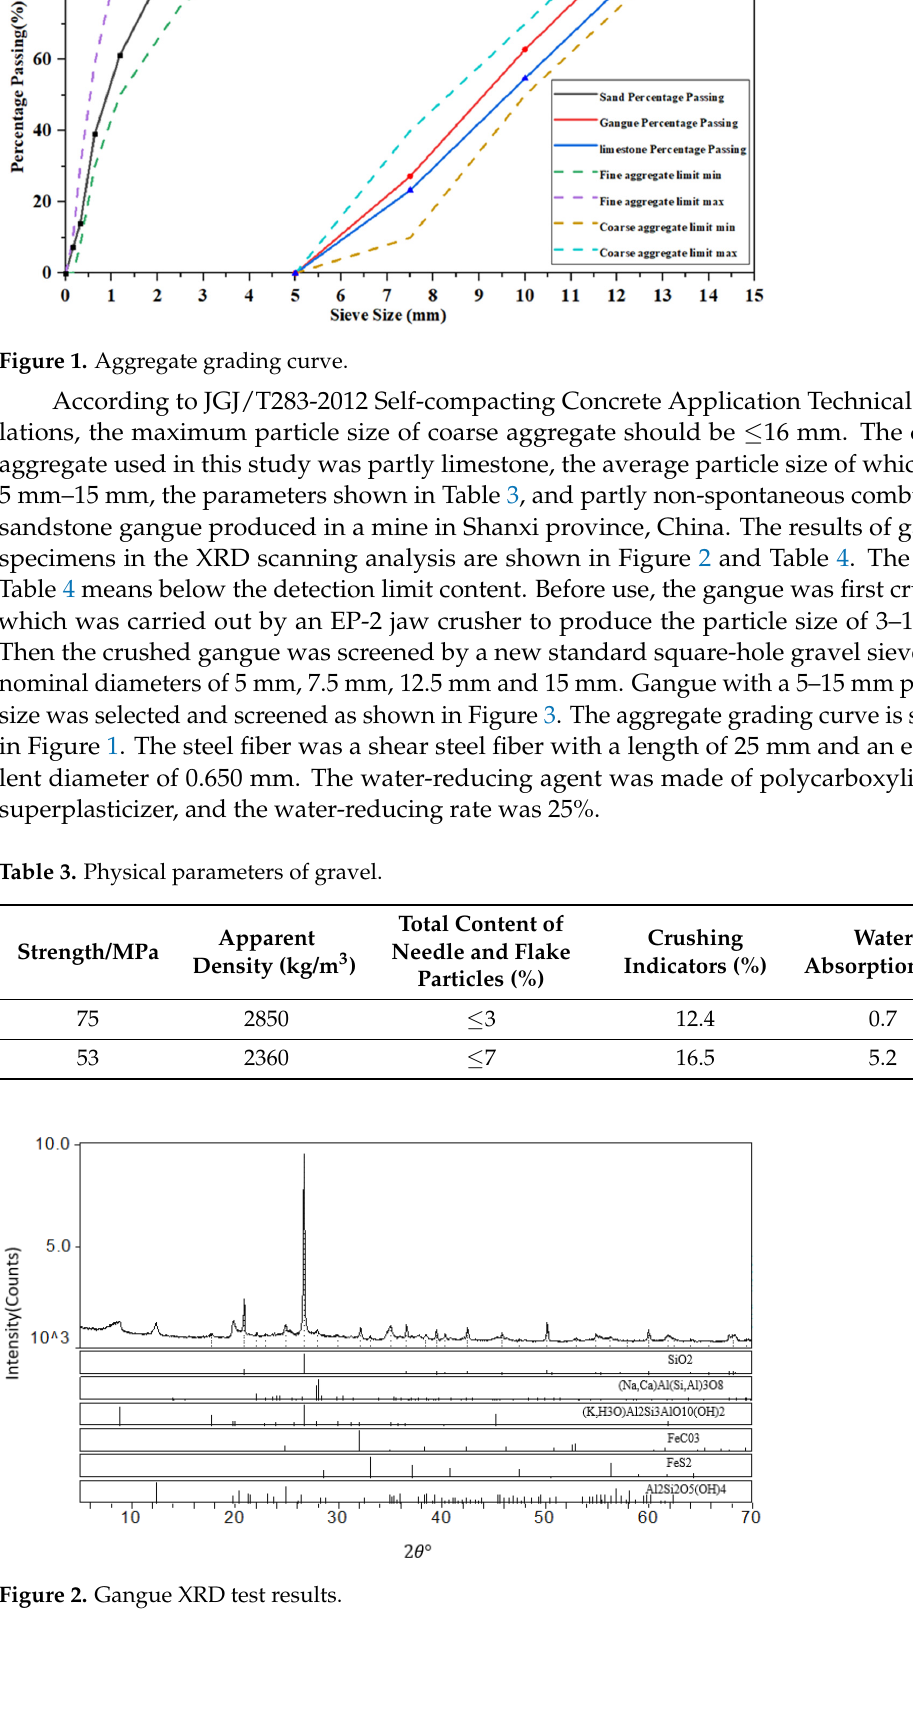
≤ 0.02 Table 3. Physical parameters of gravel. Strength/MPa